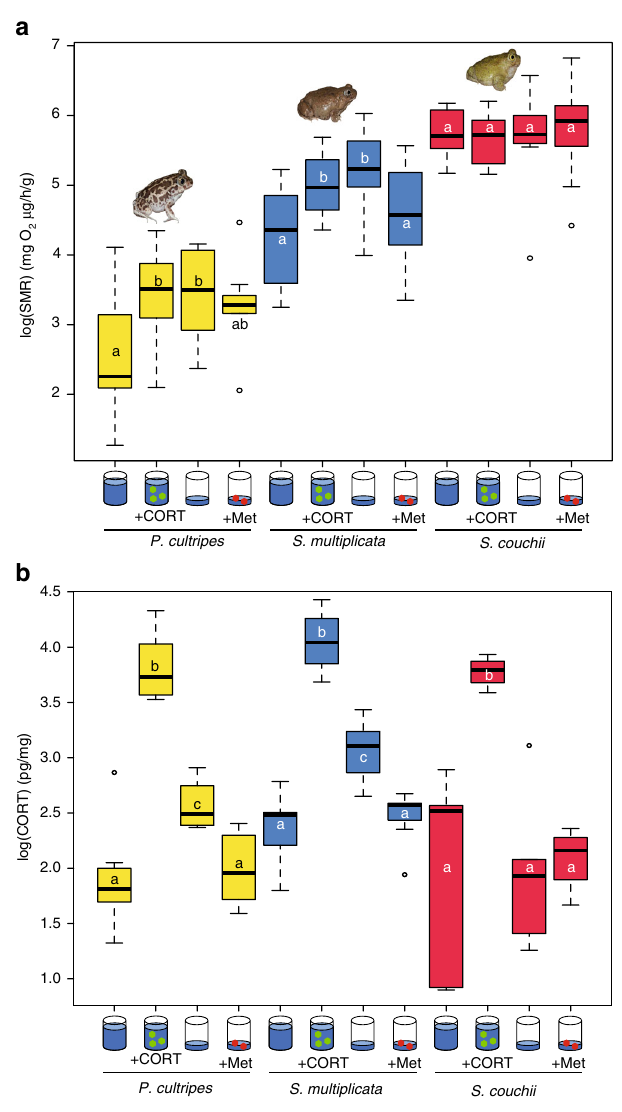
Fig. 3 Hormonal and metabolic divergence among species across treatments. a Premetamorphic tadpoles of each spadefoot species were reared in high or low water level with exogenous CORT or metyrapone (Met, a CORT synthesis inhibitor) as shown. Species showing adaptive developmental acceleration in response to pond drying ( P. cultripes and S. multiplicata ) experienced steep increases in size-adjusted SMR when faced with reduced water level, which could be mimicked by treatment with exogenous CORT in high water and impaired by treatment with metyrapone in low water. In contrast, SMR in S. couchii was unresponsive to reduced water levels or even to exogenous CORT, hence showing a canalized high level of metabolism. b Whole-body CORT content was measured after 24 h in each treatment for each species. As expected, CORT content increased after low water treatment in P. cultripes and S. multiplicata , and exogenous hormone treatment increased CORT content in all species. Importantly, metyrapone treatment blocked the low water- induced increase in CORT content in P. cultripes and S. multiplicata , but metyrapone did not reduce the constitutive CORT content in S. couchii . Letters inside the bar graphs indicate signi fi cance groups within species based on post hoc signi fi cance tests. Sample sizes were as follows for the High, High+CORT, Low, Low+Met treatmentst: P. cultripes (10, 11, 10, 9), S. multiplicata (10, 10, 8, 10), and S. couchii (10, 10, 10, 10)